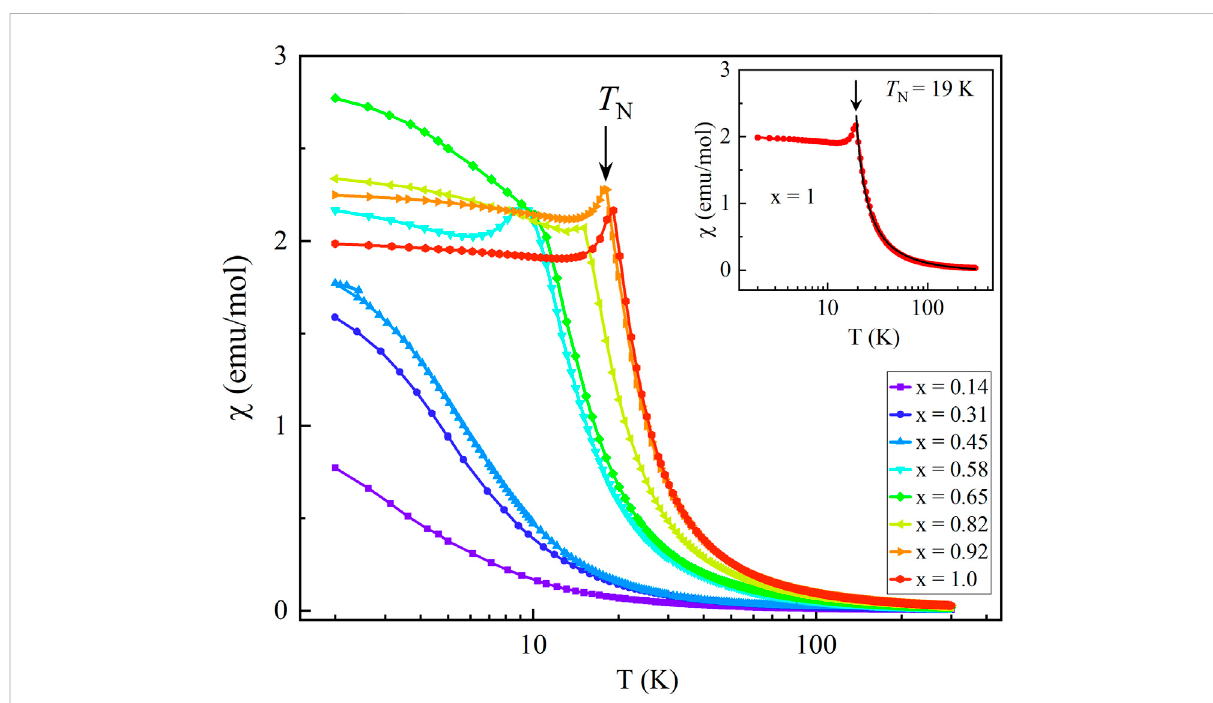
FIGURE 2 Magnetic susceptibility. Magnetic susceptibility ( χ ) vs. T for ECFA samples with different amounts of Eu doping (0.14 ≤ x ≤ 1. χ (T) increases gradually with decreasing temperature. The low-temperature anomalies, T N ~ 10 – 19 K, arise due to the Eu 2+ AFM order, as indicated by the arrow. Inset: χ (T)data forEuFe 2 As 2 ( x = 1).The solidblack curveisthebest- fi tcurveusingtheCurie-WeissmodelEq. 1. The x -axisisinthelogarithmicscale for better visibility of T N